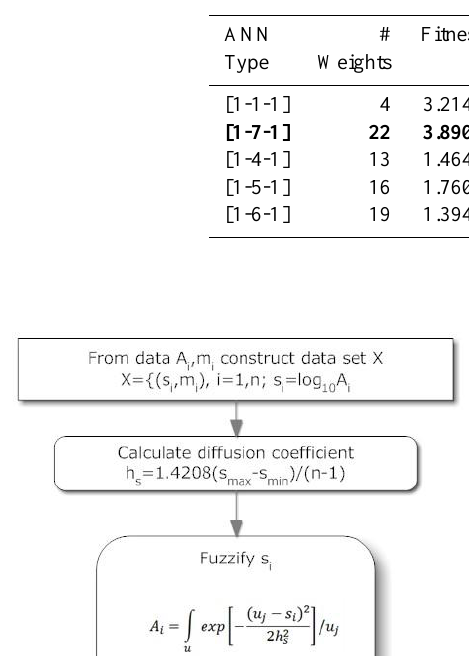
Table 2. Parameters of tested neural networks. Bold numbers correspond to the selected network.